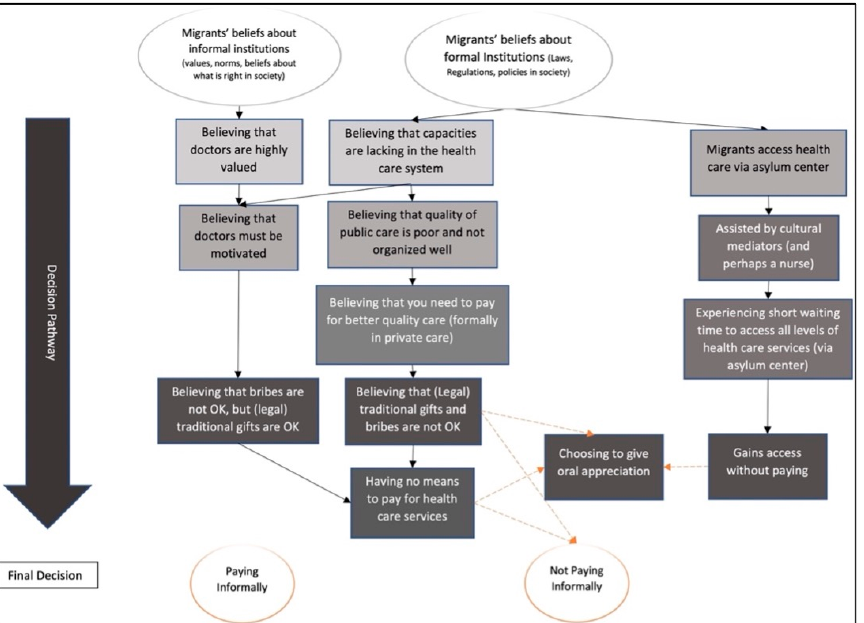
Figure 2. Illustration of potential pathways to informal patient payments perceived by migrants.